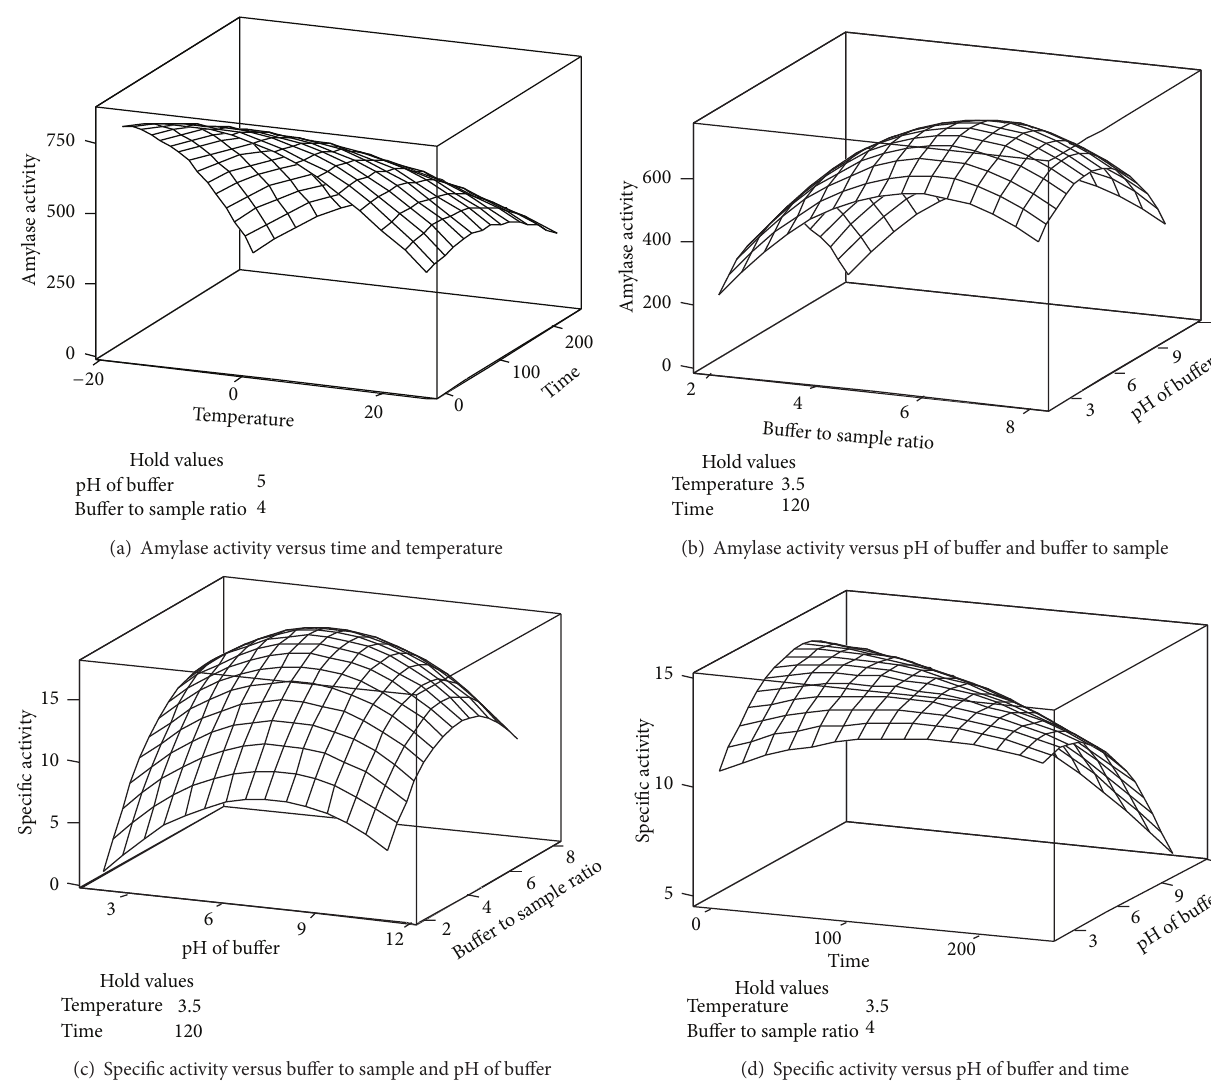
Figure 1: Three-dimensional curves for showing the significant interaction effect of independent extraction variables (e.g., temperature, time of mixing, pH of buffer, and buffer to sample ratio) on activity (a-b) and specific activity (c-d) of amylase were